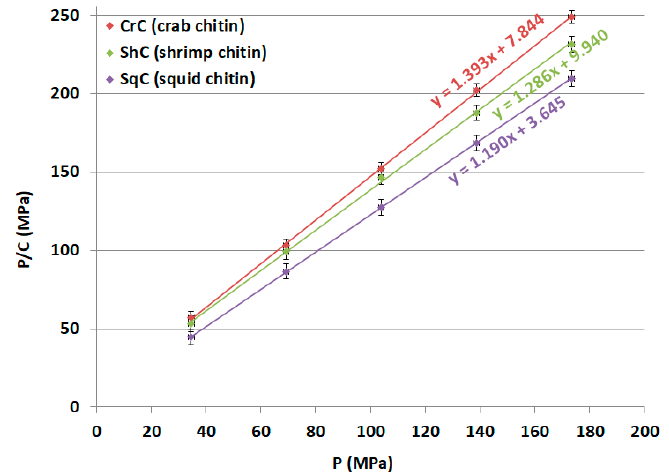
Figure 7. Kawakita plots of crab (CH-Cr), shrimp (CH-Sh), and squid (CH-Sq) CHs.